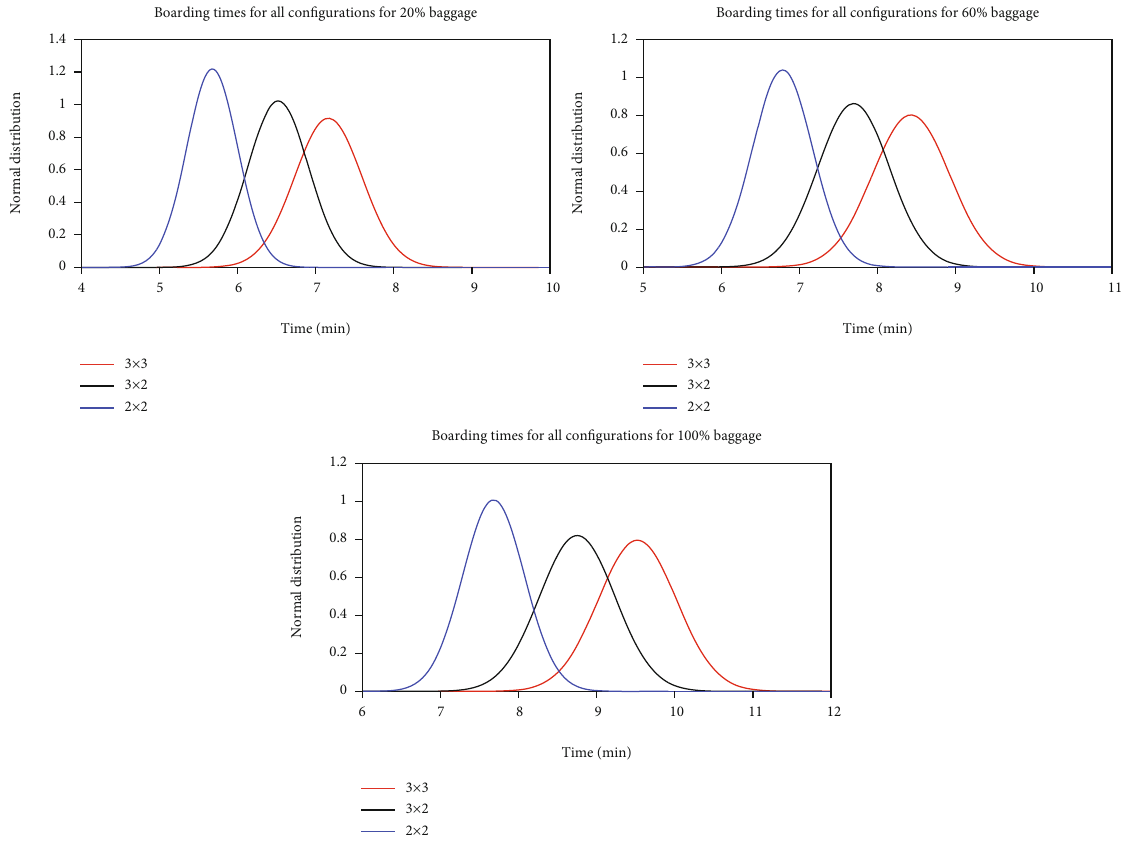
Figure 12: Fitted normal distribution curves for each aircraft con fi guration using the random boarding strategy for di ff erent % of